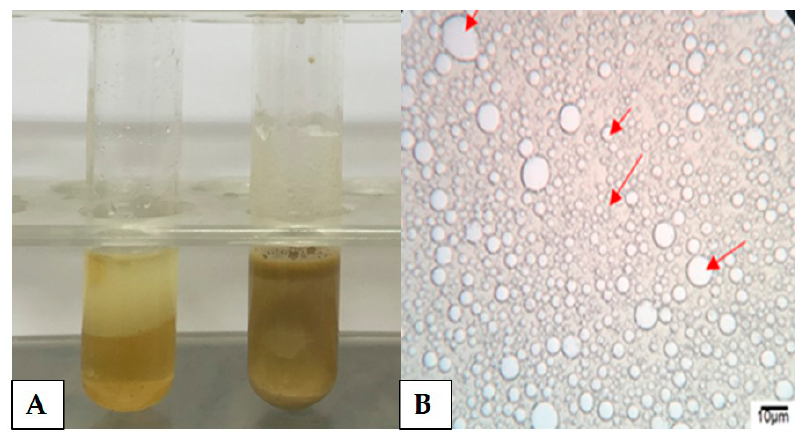
Figure 1. Macroscopic appearance of emulsions formation by Mucor circinelloides bioemulsifier using canola oil (near A letter) and burnt engine oil (near B letter), respectively ( A ), and microscopic analysis of the emulsion formed by the bioemulsifier in burnt engine oil ( B ).